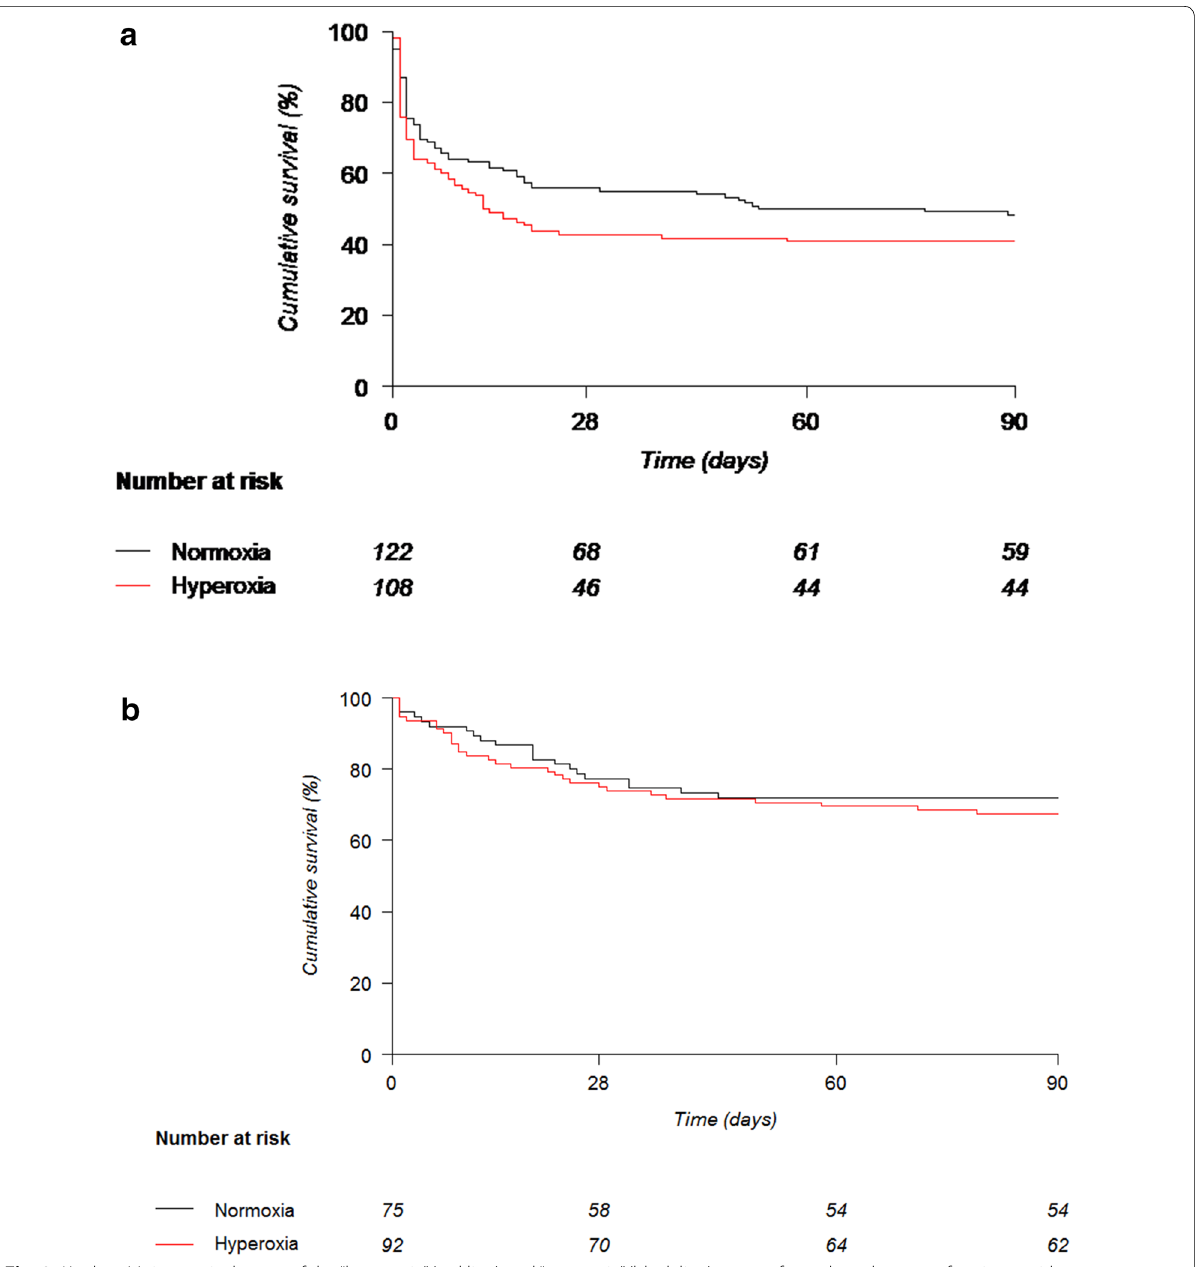
Fig. 2 Kaplan–Meier survival curve of the “hyperoxia” (red line) and “normoxia” (black line) groups for: a the subgroup of patients with hyperlactatemia > 2 mmol/L at baseline. Log-rank test between the two randomization arms, p b The subgroup of patients with lactatemia day 28 and 90,